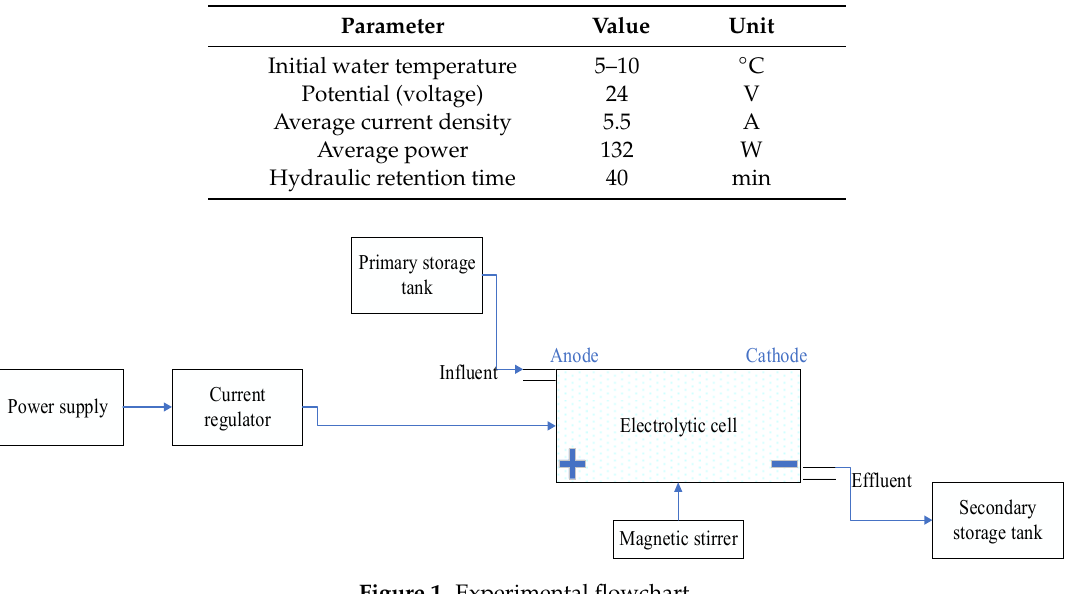
Table 2. General technical specifications.